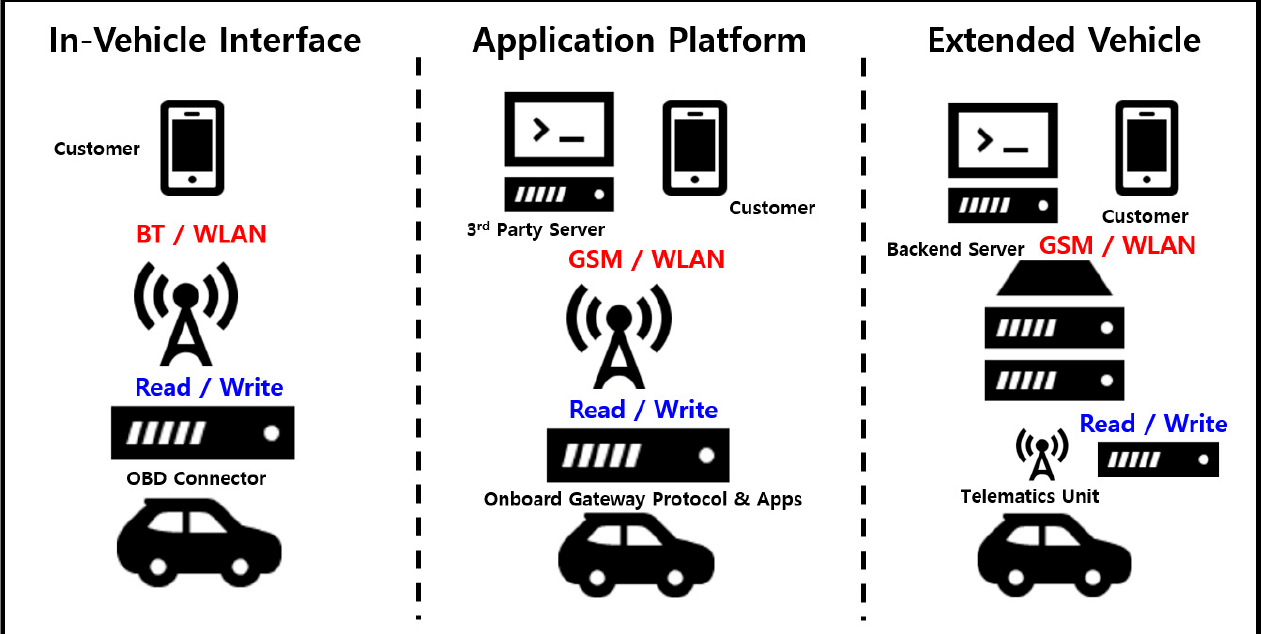
Figure 1. Interface for Supporting Automobile Cloud Services (Source: ISO TC22/SC31 WG6, 2020).